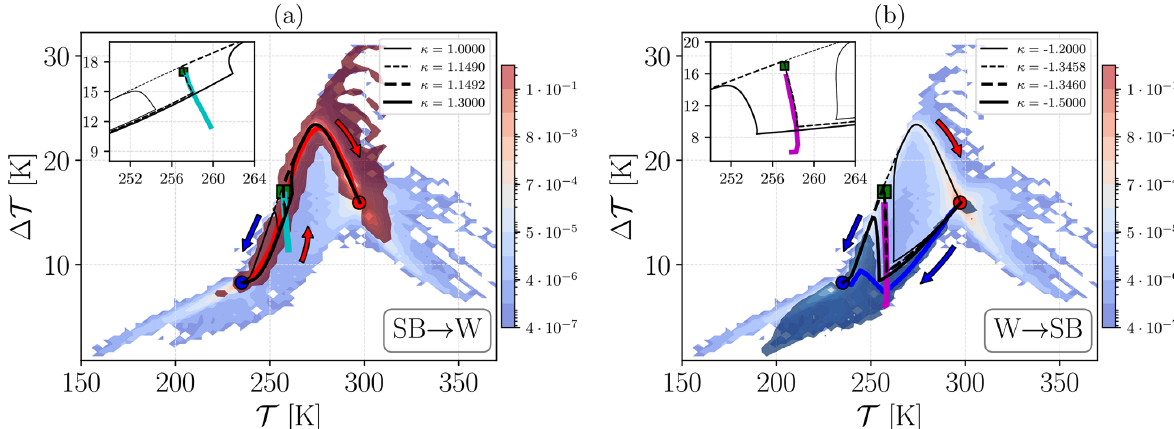
Figure 6. Comparison between the supercritical and subcritical paths that are constricted, using singular perturbations and the ensemble of trajectories corresponding to Lévy noise-induced transitions. (a) SB → W transitions. (b) W → SB transitions. Singular perturbations are where the subcritical paths are depicted as thin solid and dashed lines. The supercritical paths, leading to transition, are depicted as thick solid and dashed lines. See the text for further details. Here, α = 1 . 0 and (cid:15) = 0 . 004.